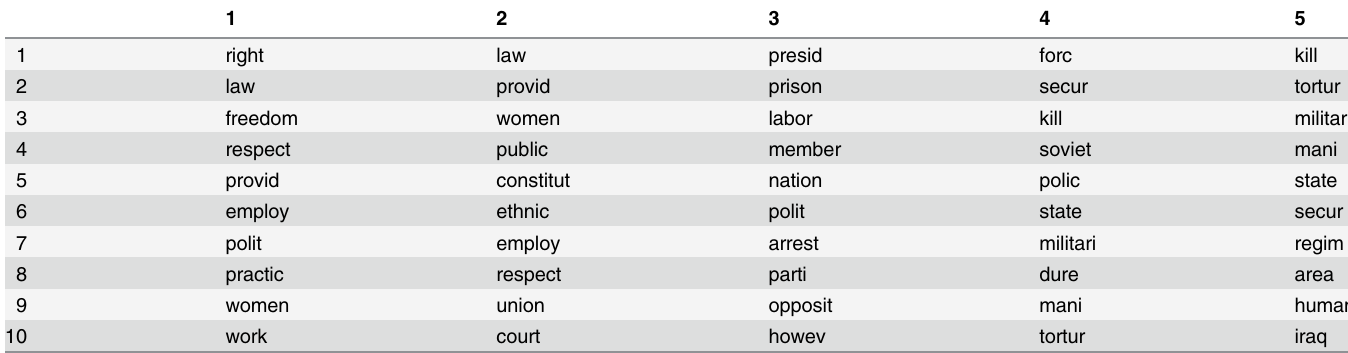
Table 14. Ten most important words for Hathaway torture